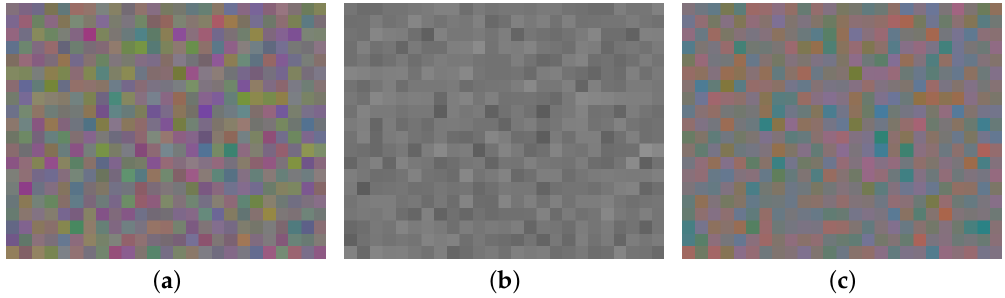
Figure 12. If a grey uniform scene is taken with a color camera under dim light ( a ), one can separate its luminance ( b ) to its chrominance ( c